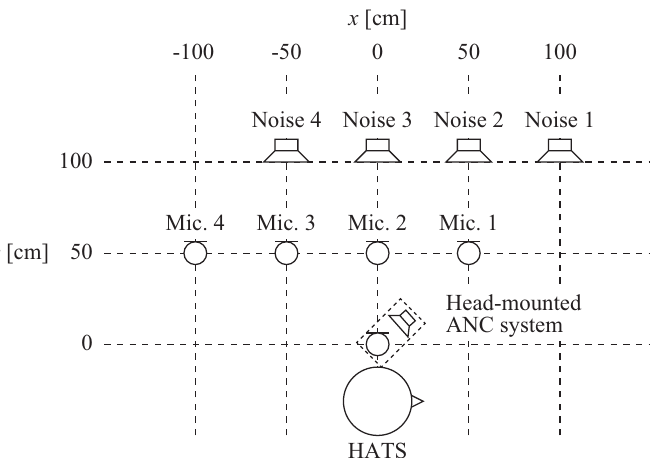
Figure 7. Arrangement of equipment in the experiment.